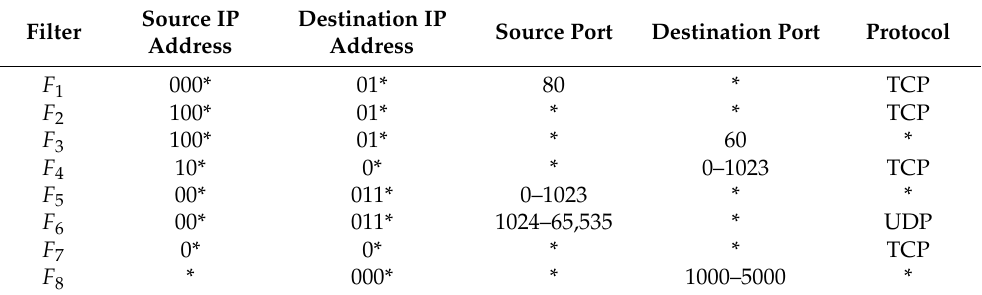
Table 2. An example of a 5D filter